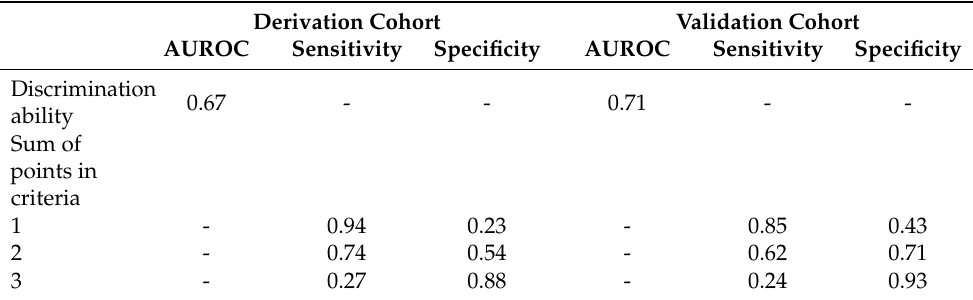
Table 2. Predictive ability of criteria developed for PICS in derivation and validation cohorts.